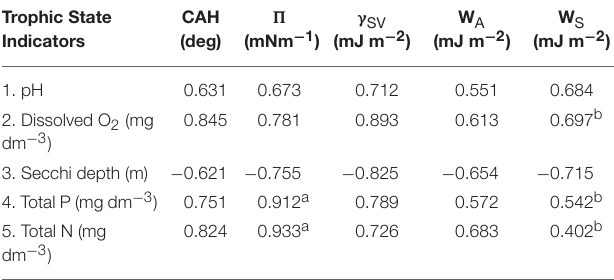
TABLE 1 | Spearman’s rank correlation coefficients between the trophic status indicators and wettability parameters of glass substrata submerged in Baltic Sea coastal